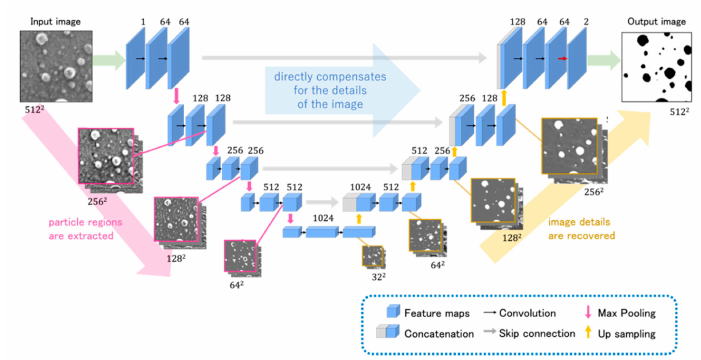
Figure 2. Conventional